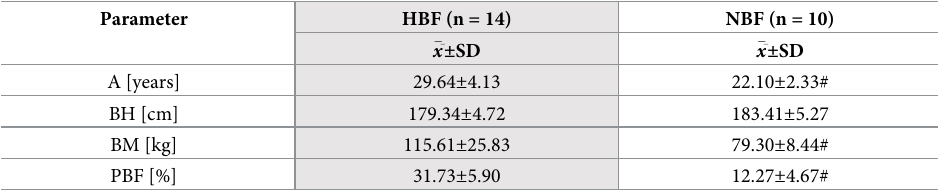
Table 1. Anthropometrical characteristics of the